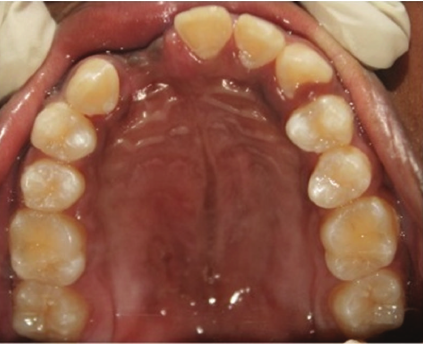
Figure6:6-monthpostoperativephotographshowinggoodhealing of the palate with no recurrence of the